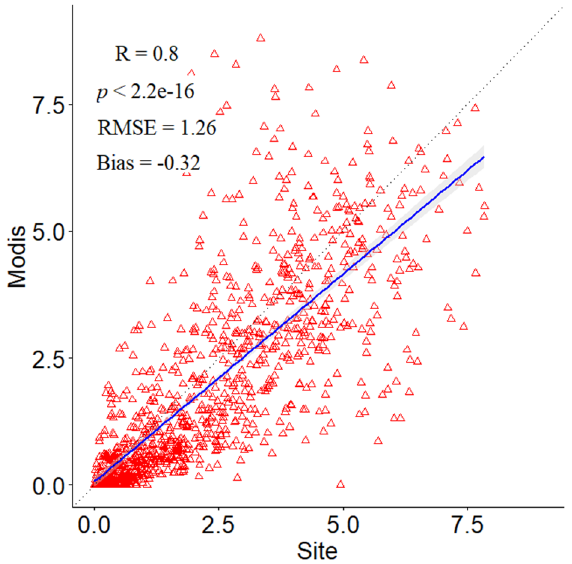
Figure 8. The overall scatterplots of in situ based GPP against MOD17A2H. Flux tower GPP means in situ GPP. Gray belt refers to the confidence interval of 95%.